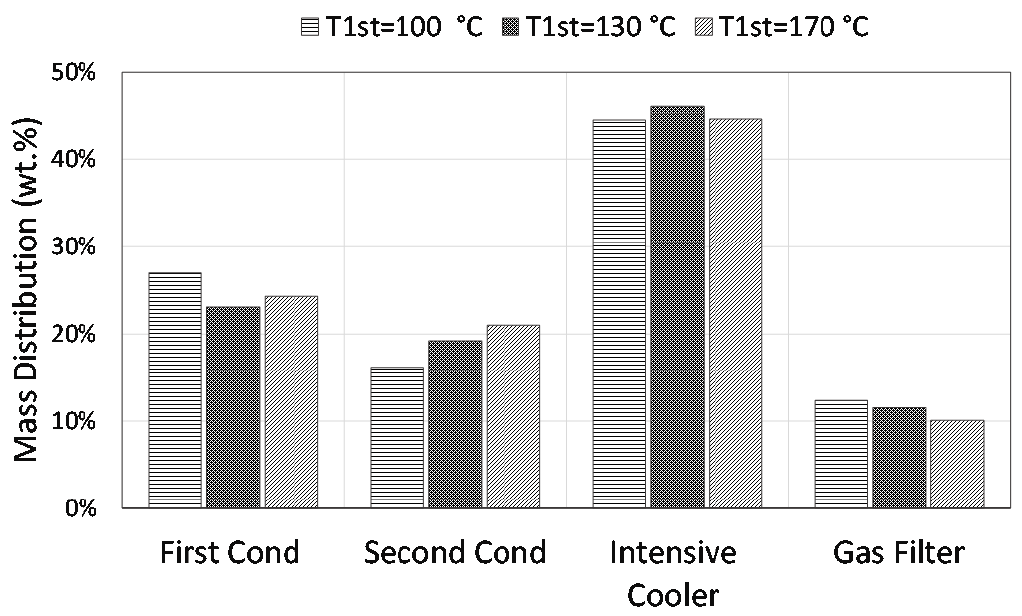
Figure 8. Mass distribution of bio-oil, Spray Condensers setup.